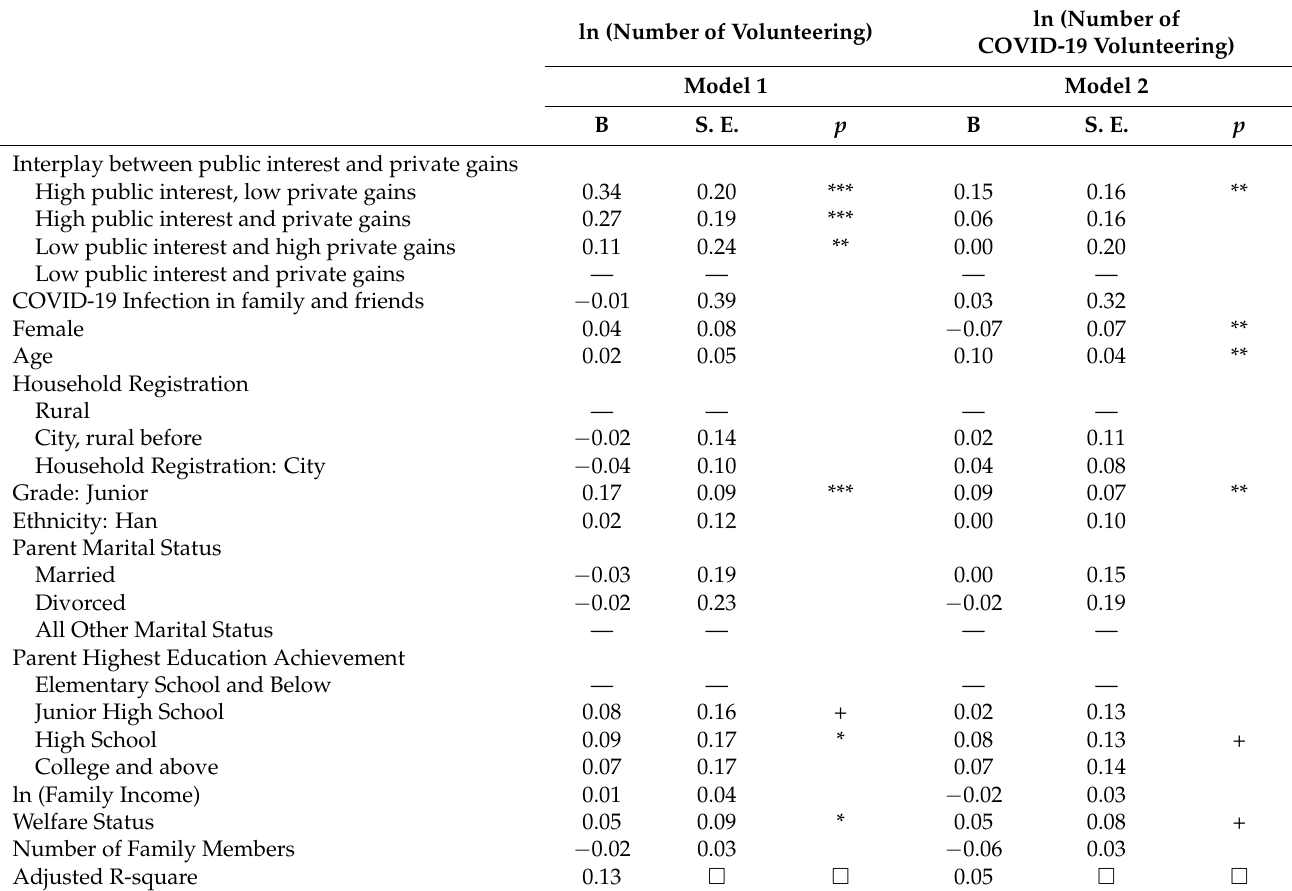
Table 3. OLS Regression of Number of